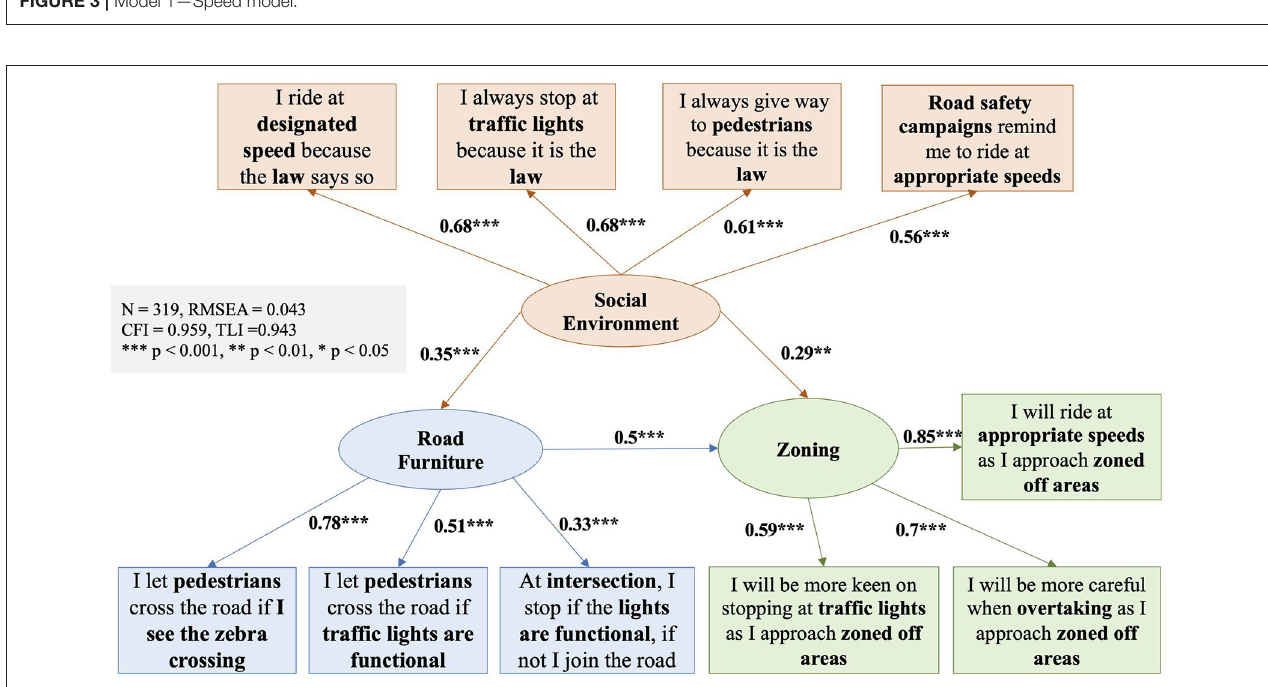
FIGURE 3 | Model 1—Speed model.